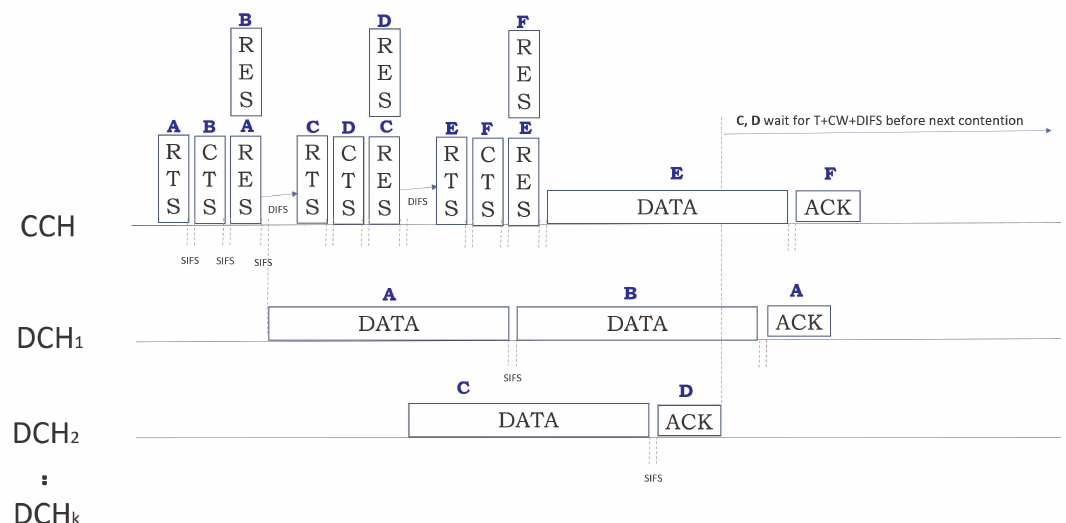
Figure 1. The spectrally efficient asynchronous multi-channel medium access control (SA-MMAC)